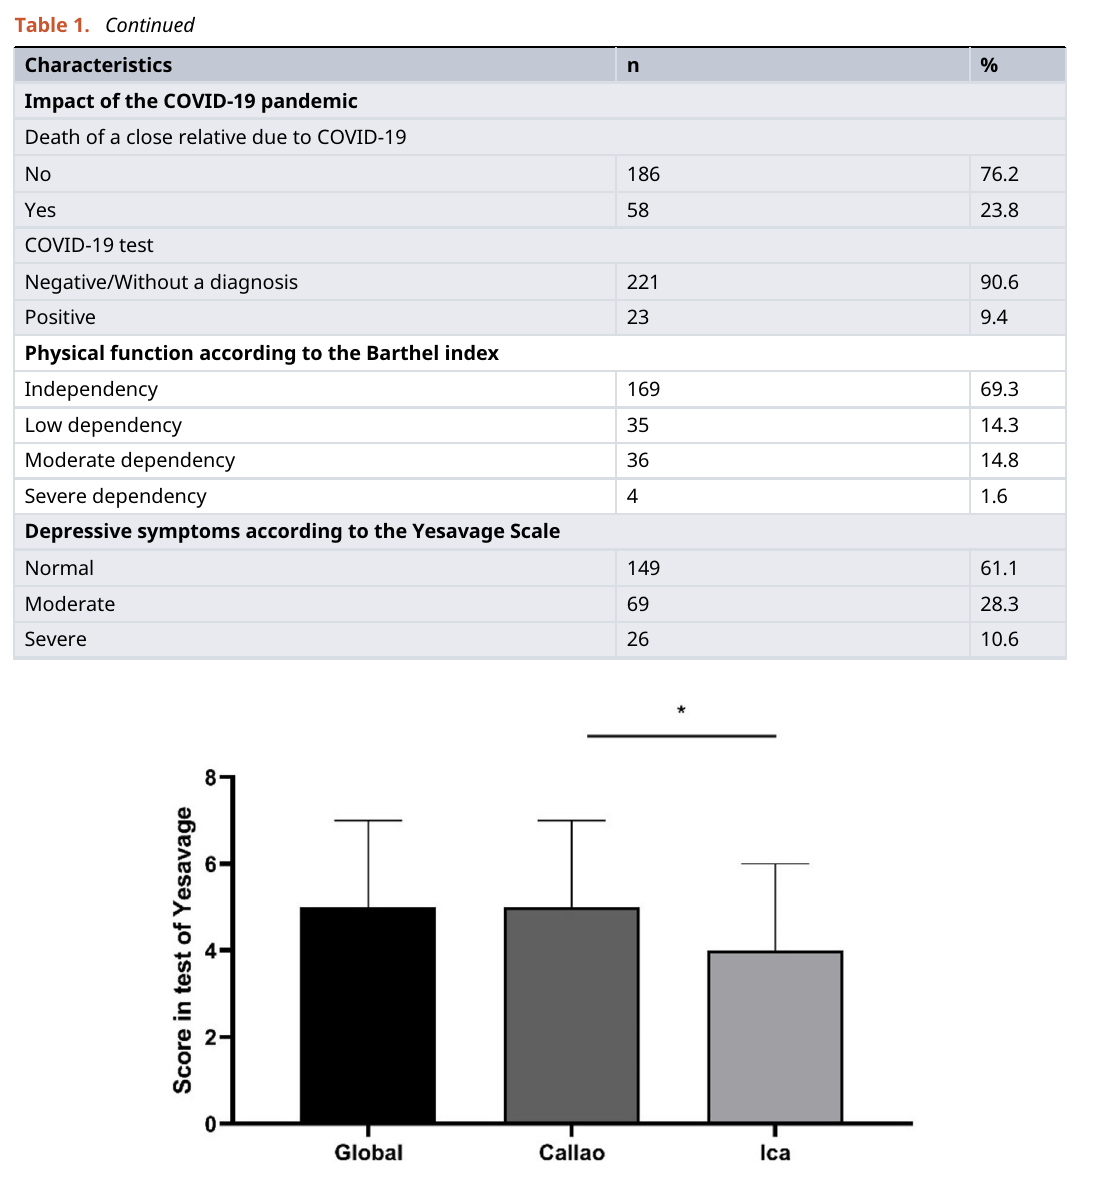
Figure 2. Scores obtained by older adult participants on the Yesavage Scale during the COVID-19 Pandemic in two regions of Peru. Error bars represent the median and interquartile range, respectively. *p = 0.028 in the Mann- Whitney